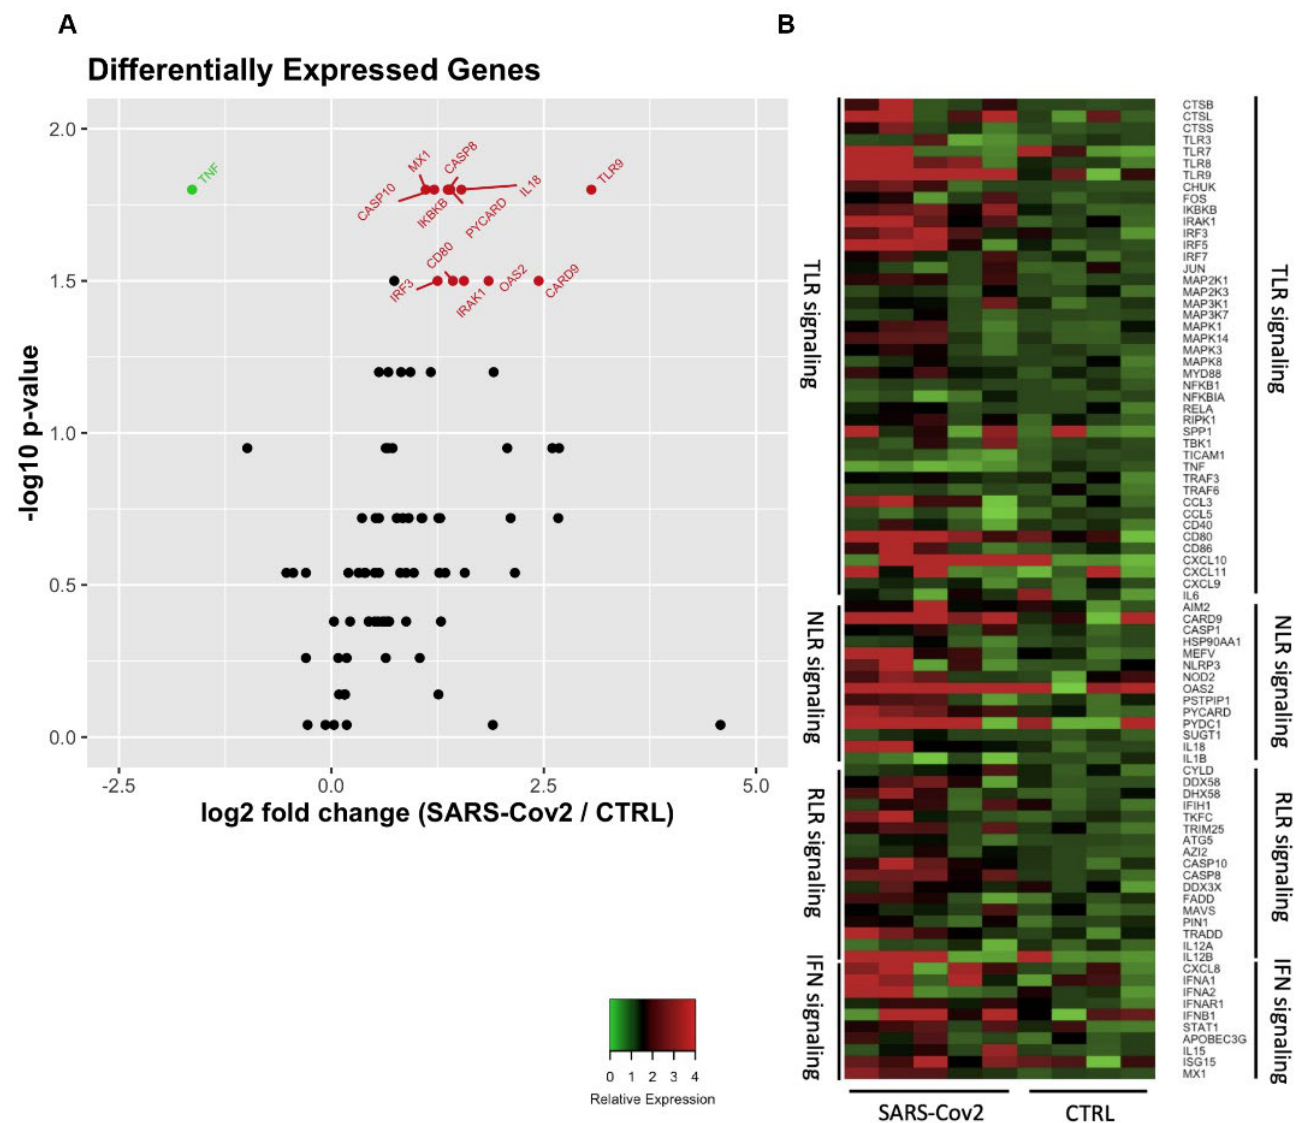
Figure 6. Differentially expressed genes of the signaling pathway of innate immunity and anti − viral factors in CD8+ T lymphocytes in severe COVID-19. ( A ) Expression of antiviral factors by PCR array of 84 genes of CD8+ T lymphocytes from individuals with severe COVID-19 compared to uninfected. The red dots represent the upregulated genes in severe SARS-CoV-2 infection, the green dot represents the downregulated gene, and black dots represent genes that do not change. ( B ) Heatmap of expression of antiviral factors of CD8+ T lymphocytes from uninfected ( n = 6) and infected individuals with severe COVID-19. Genes are divided into groups according to the associated signaling pathway: Toll-like receptor (TLR), NOD − like receptor (NLR), and RIG − like receptor (RLR).